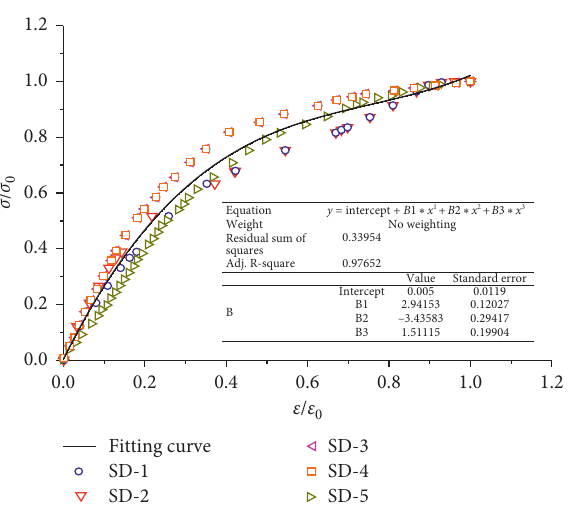
Figure 25: The stress-strain fitting curve of the